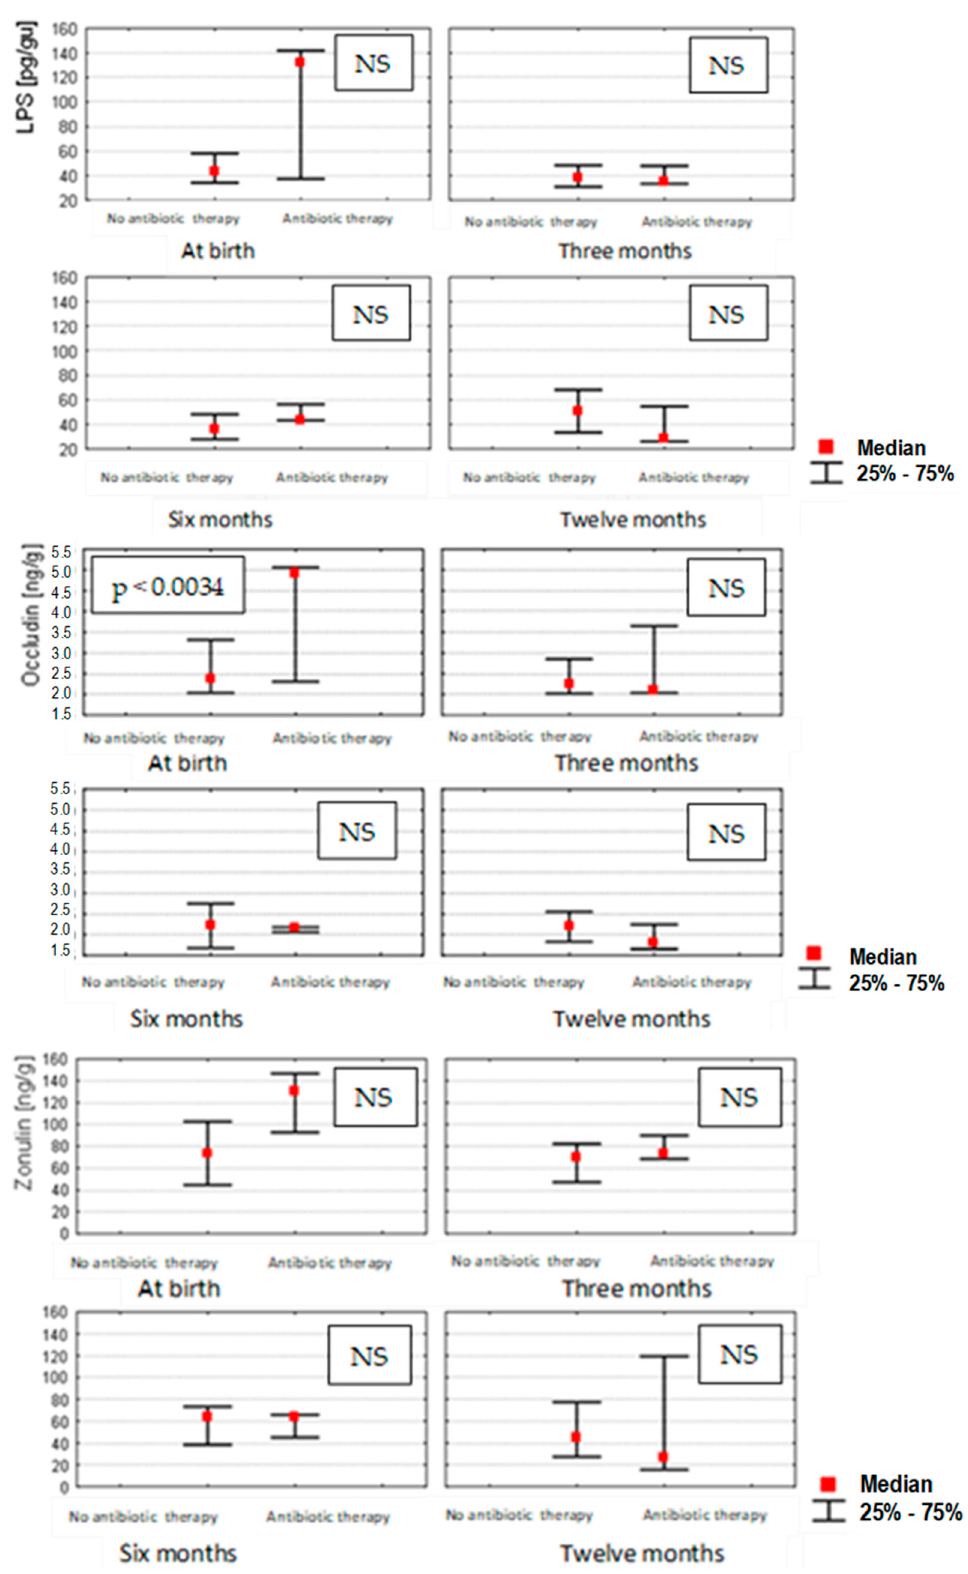
Figure 3. Stool concentrations of studied parameters at birth ( n = 100), in 3 ( n = 96), 6 ( n = 90) and 12 ( n = 84) month-old children depending on exposure to antibiotic therapy during pregnancy (Mann– Whitney U test and Kruskal–Wallis test; a p -value ≤ 0.05 was considered statistically significant. NS: non-significant ).